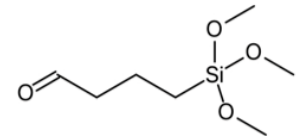
Figure 1. Trimethoxysilane aldehyde (TMSA).